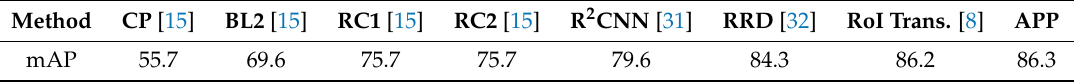
Table 4. Comparisons with the state-of-the-art methods on HRSC2016